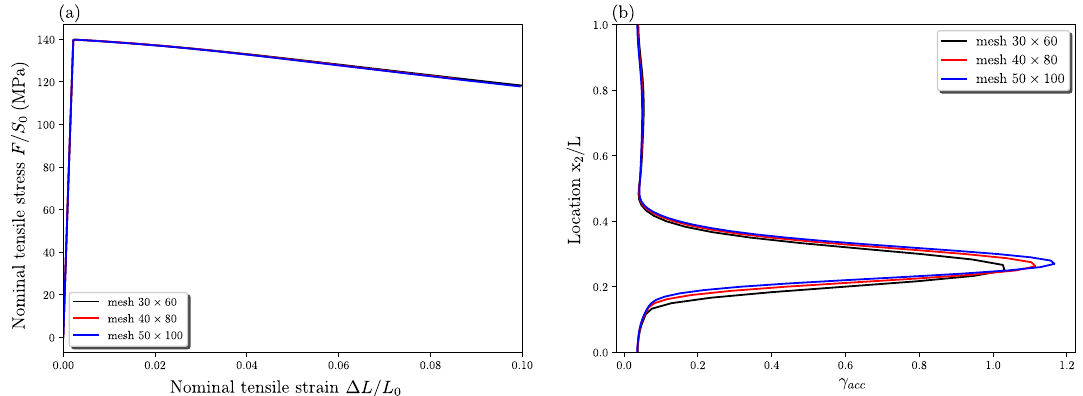
Figure 9. The results of uniaxial tension with two slip systems: ( a ) nominal stress–strain curves and ( b ) accumulated plastic slip variable distributions along the x 2 − direction at ∆ L / L 0 = 0.1 for different mesh refinements ( l en / W = 0.2, l dis = 0, H π = − 500 MPa